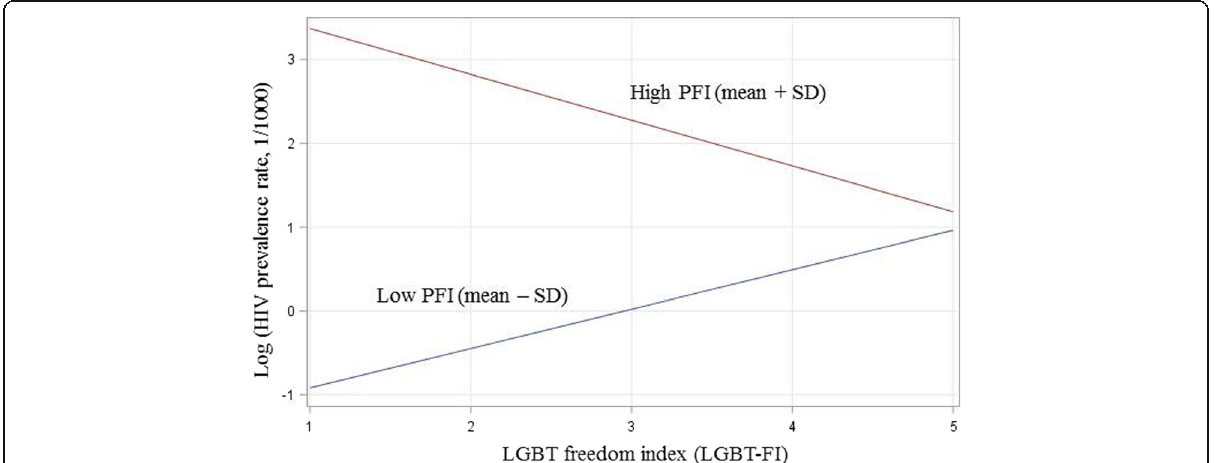
Fig. 4 Interaction between press freedom index (PFI) and LGBT freedom index (LGBT-FI) in association with PLWH prevalence across 148 countries in the world (Source: Created with data from the UNAIDS, Doctors Without Borders, and Wikipedia